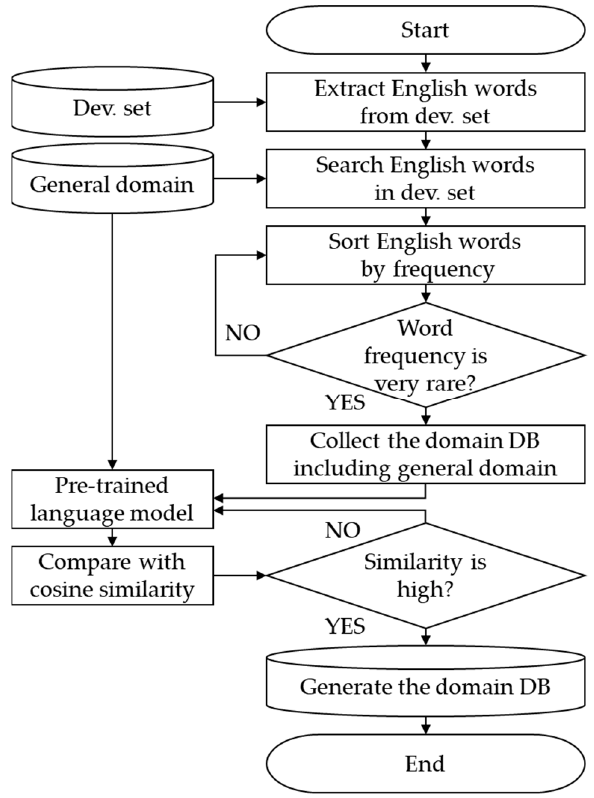
Figure 7. Block diagram of the sentences semantically similar to the target domain. Dev. set, development set; DB, database.